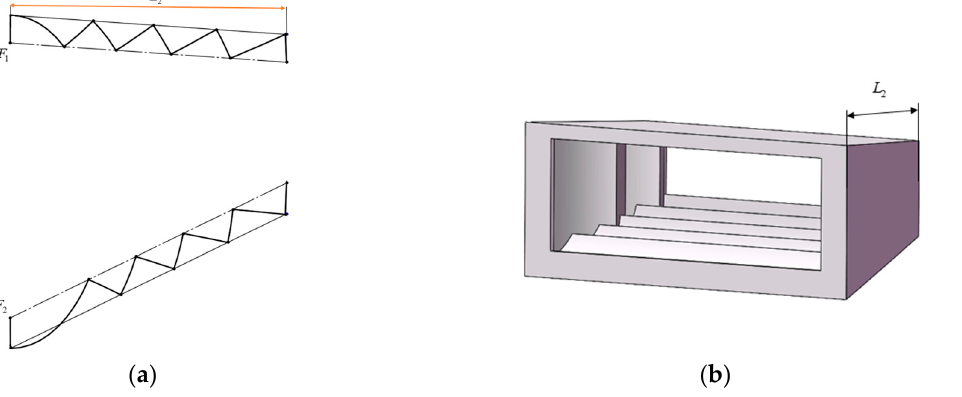
Figure 6. Design result of the inner baffle. ( a ) Design principle of the inner baffle; ( b ) structure model of the inner baffle.